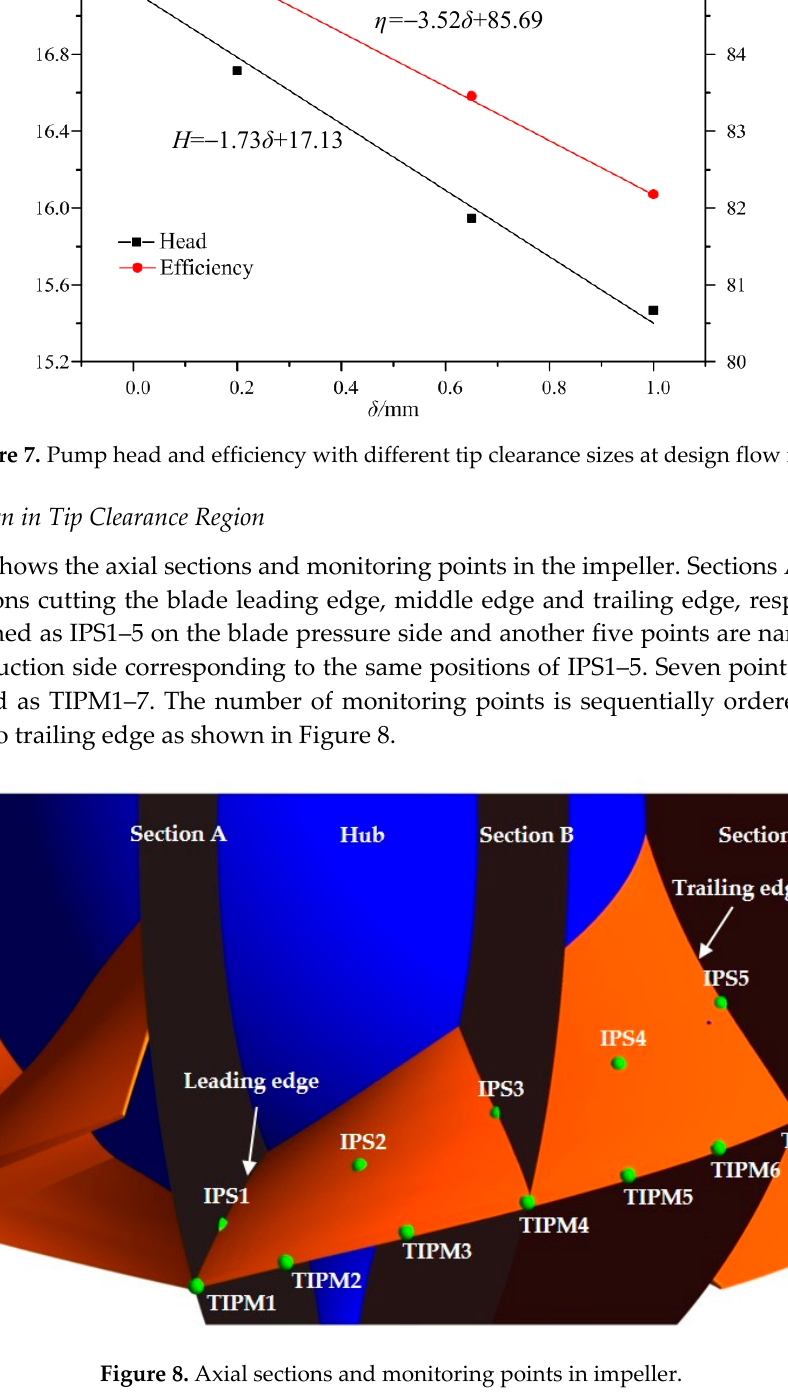
Figure 8. Axial sections and monitoring points in